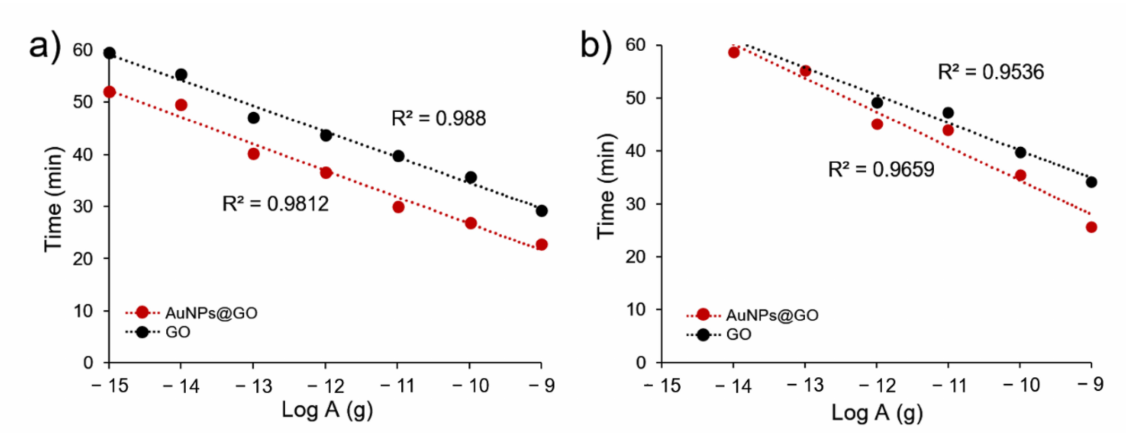
Figure 4. Standard curves of detection time versus amount of gene material using ( a ) FMDV serotype O and ( b ) FMDV serotype A